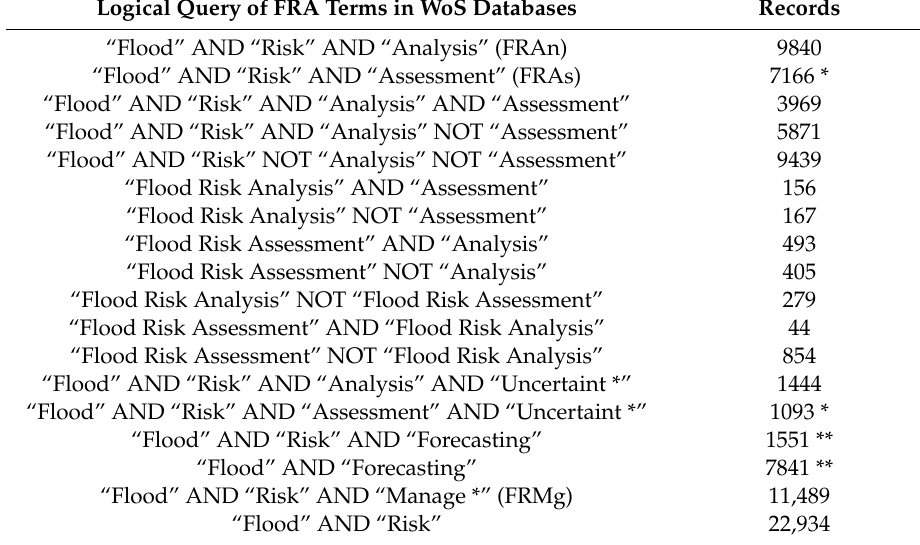
Table 1. List of di ff erent logical queries using the flood risk analysis and assessment (FRA) terms in the WoS databases and the obtained records (updated at 22 June 2020; * updated at 19 January